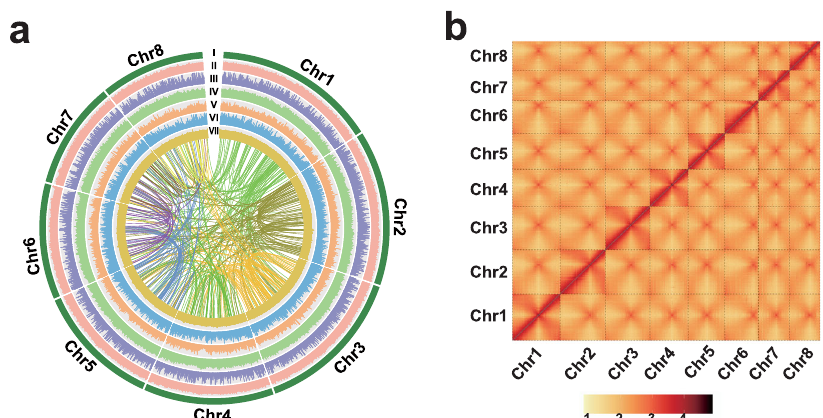
Fig. 1 | High-quality genome assembly of the A. fi stulosum . a The rings indicate eight chromosomes (I), TE density (II), gene density (III), Gypsy retrotransposons density (IV), Copia retrotransposons density (V), Long interspersed nuclear